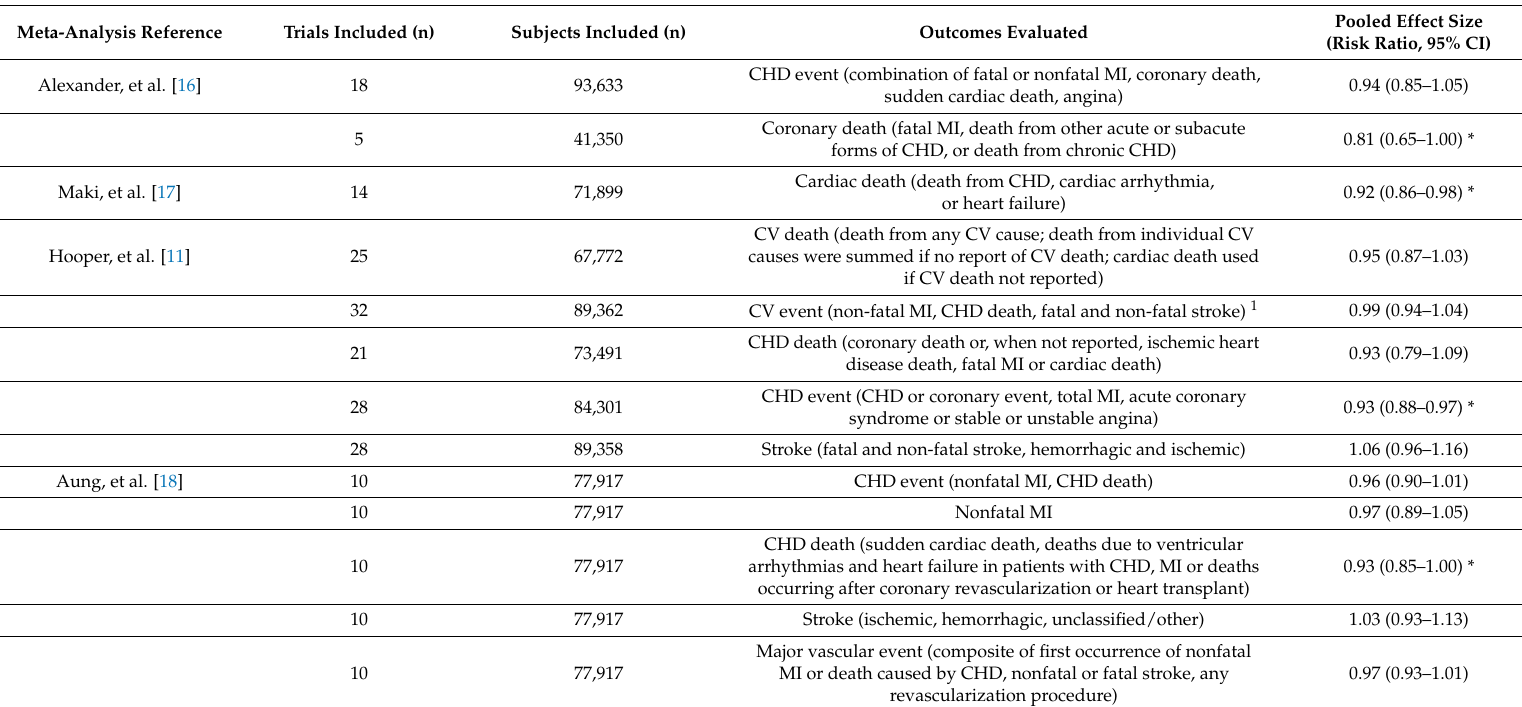
Table 1. Characteristics and selected results from four recent meta-analyses of data from randomized controlled trials of long-chain omega-3 polyunsaturated fatty acid administration compared to control or no